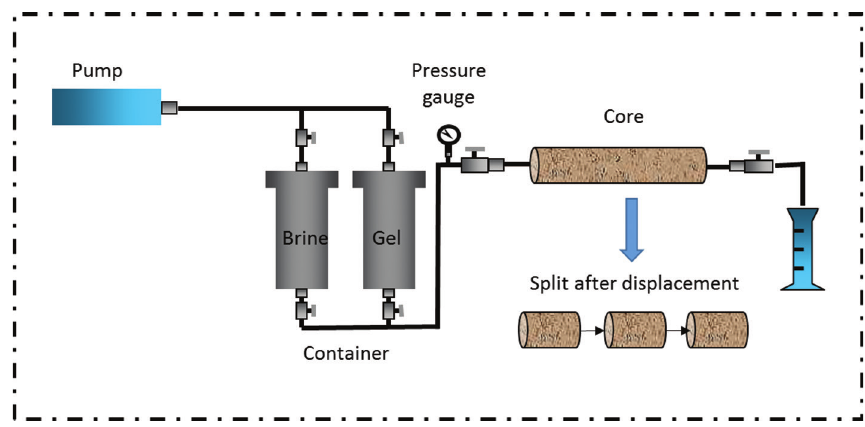
Figure 1: Diagram of oil displacement